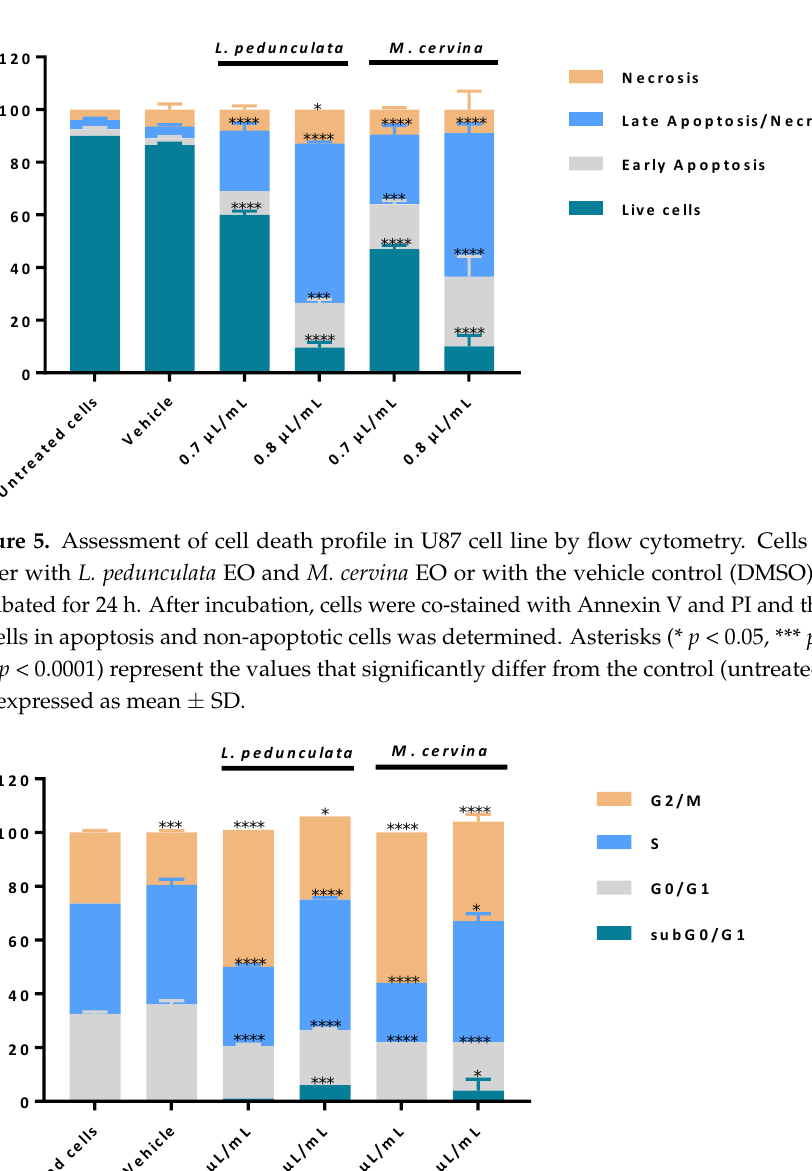
15 of 20 standard GB cell model (U87 cell line). Based on that, a cell death profile was made using AV/PI assay, which enables us to distinguish live cells from cells in apoptosis and from cells in necrosis. AV-binding assay is one of the most used experiments to detect apoptosis, via the activation of caspases. In apoptotic stages, caspases cleave the lipid flippases in the inner leaflet of the plasma membrane, which exposes the phosphatidylserine (PS) to the outer leaflet layer of the cell membrane. Thus, at this stage, the PS is recognized by the AV (stoi- chiometric binding reaction), an indicative process of early apoptosis [45,66]. On the other hand, in late apoptosis and/or necrosis, the integrity of the plasma and nuclear mem- branes is greatly decreased, making it more permeable and therefore allowing for the pas- sage of the PI fluorochrome. Once the PI passes through the membrane, it binds to the DNA and stains the nucleus. It is important to note, however, that this process only hap- pens in cells whose membranes have become permeable (non-viable cells), and it cannot happen in live or in early apoptotic cells due to the presence of an intact plasma membrane [45,67,68]. Thus, by performing a double staining assay based on these two methods, it is possible to ascertain if cells are viable, apoptotic, or necrotic through alterations in plasma membrane integrity and permeability, since the transport of PS to the outer cell membrane allows for the penetration of the PI fluorochrome into the cell in a unidirectional manner. The analysis of the results obtained showed that cells treated with both concentra- tions, 0.7 and 0.8 µL/mL, of either L. pedunculata or M. cervina EOs promoted a significant decrease in the % of live cells (Figure 5), which supports our previous results (Figures 2 and 3). Moreover, treatment with both EOs led to a substantial increase of cells in late apoptosis/necrosis, which was accompanied by a significant increase in the % of cells in early apoptosis (Figure 5). However, 0.7 µL/mL of L. pedunculata EO was the exception to this pattern, with only a significant increase of cells in late apoptosis/necrosis (Figure 5). Once more, these data are in accordance with literature already reported for EOs with a similar chemical composition. As an example, Duymus et al. [69] reported the EO from Vitex agnus-castus L. fruit, enriched in 1,8-cineole, showed high apoptotic activity against both A549 (human lung adenocarcinoma cells) and MCF-7 cells [69]. Another work stated that treatment with Ziziphora tenuior L. EO (with a high content in pulegone) on colorectal cancer epithelial cells (HT-29) revealed a time-dependent apoptosis mechanism [70]. It is worth mentioning that the reason for these apoptotic events in these studies seems to be